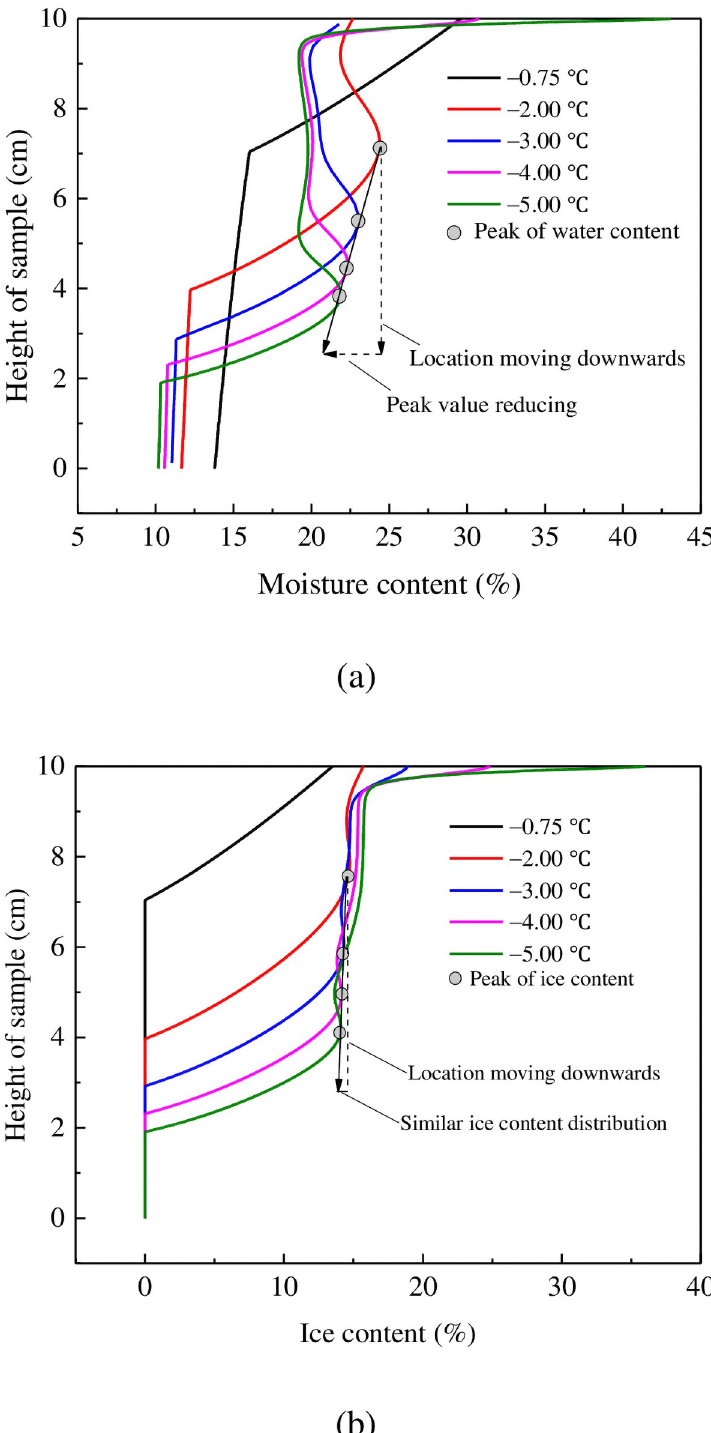
Fig 8. Calculated characteristics of moisture redistribution in soil samples with different soil-top temperatures: (a) volumetric moisture content; (b) volumetric ice content.